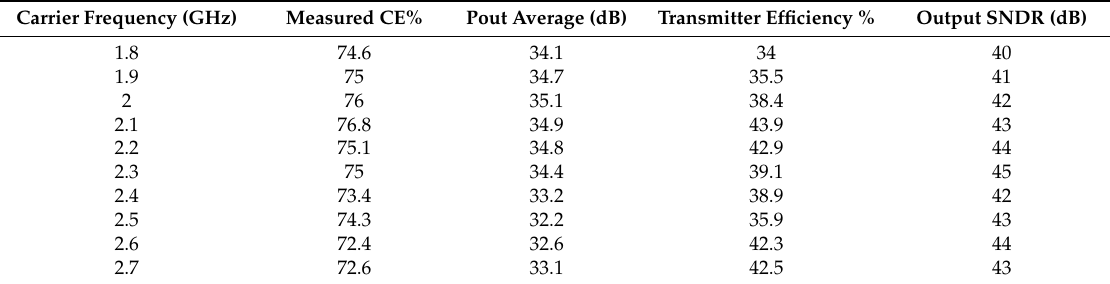
Table 5. Transmitter performances over the covered